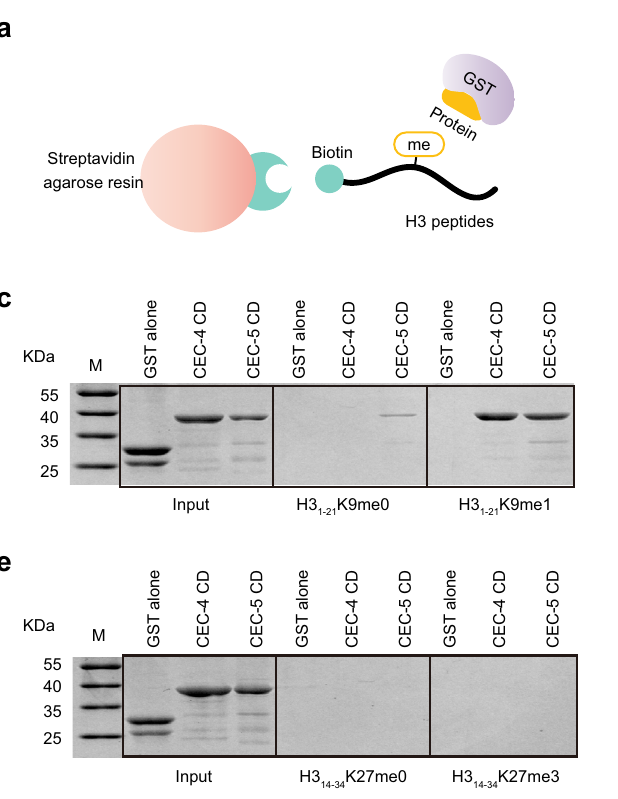
Fig. 6 | The chromodomain of CEC-5 binds H3K9 peptides in vitro. a Schematic diagram of the histone peptide pull-down assay. b Schematic diagram of the GST- tagged CEC-5 chromodomain (CEC-5 CD) and CEC-4 chromodomain (CEC-4 CD). c – f Coomassie blue-stained SDS ‒ PAGE gels showing binding of the indicated pro- teins to biotinylated histone H3 peptides. GST alone served as a negative control.